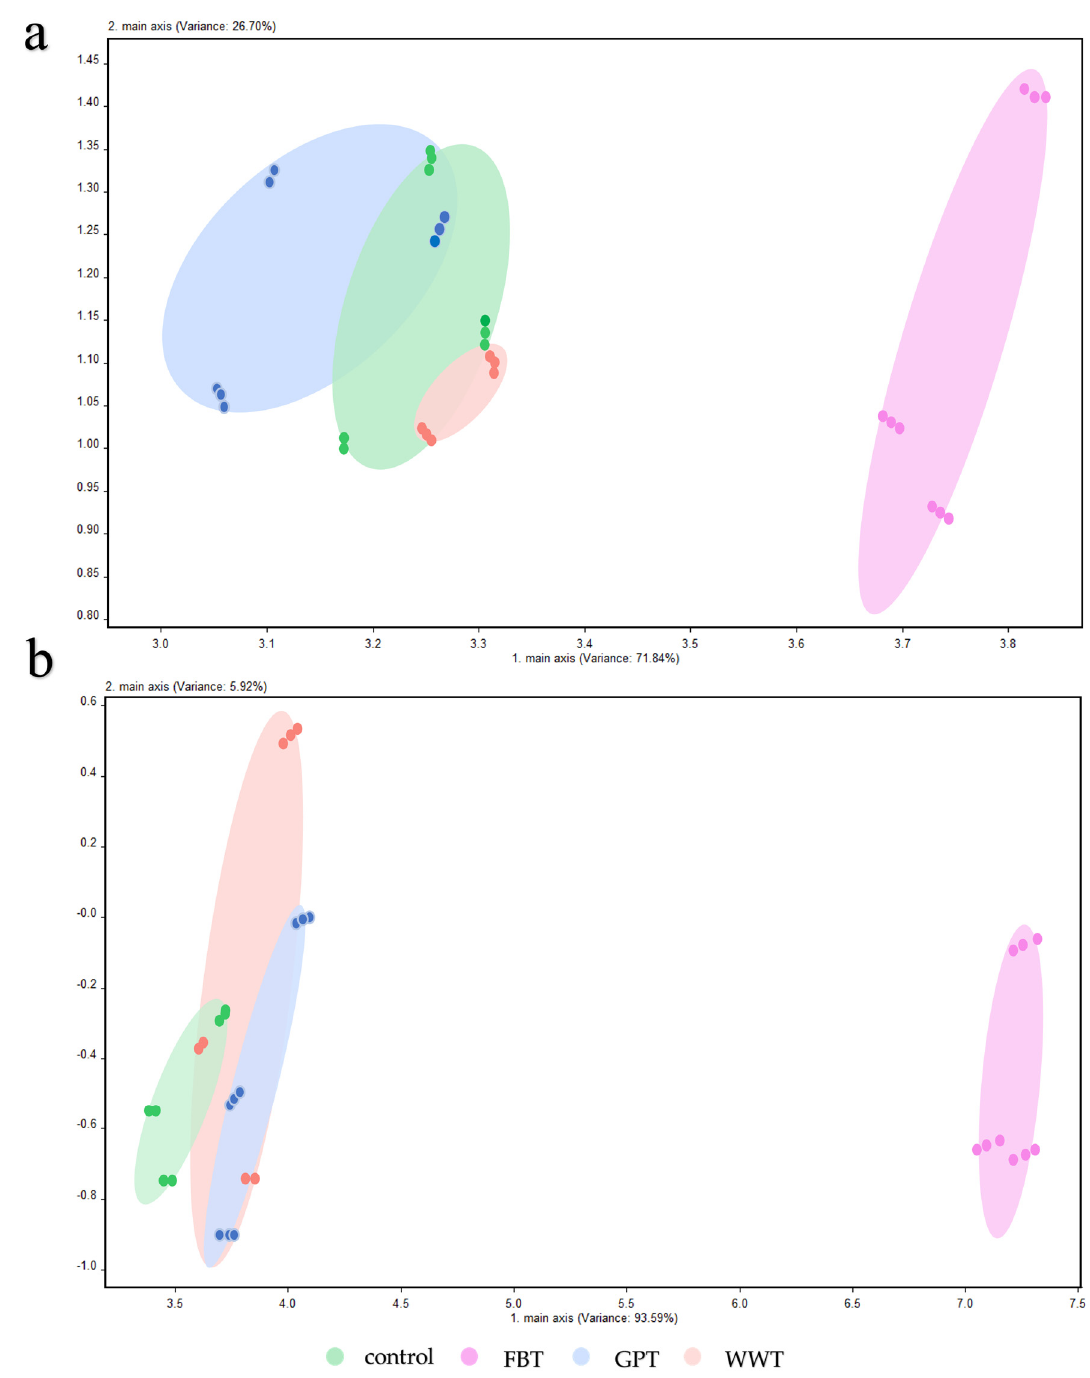
Figure 3. PCA analyses of flavor characteristics from the muscle ( a ) and skin ( b ) samples in the four modes. FBT, faba bean treatment; GPT, grass powder treatment; WWT, waving water treatment with commercial